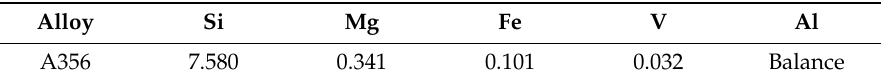
Table 1. Chemical composition of A356 aluminum alloy